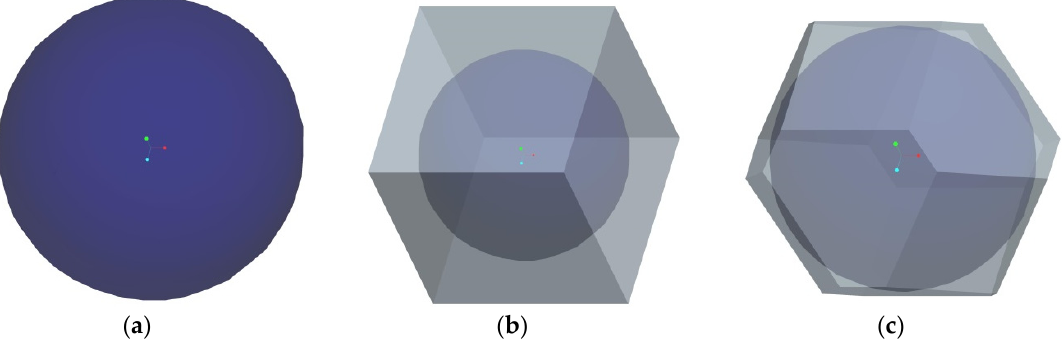
Figure 8. The corresponding HGM stacking elements: ( a ) the single HGM stacking element; ( b ) the cubic HGM stacking element and ( c ) the truncated octahedron HGM stacking element.